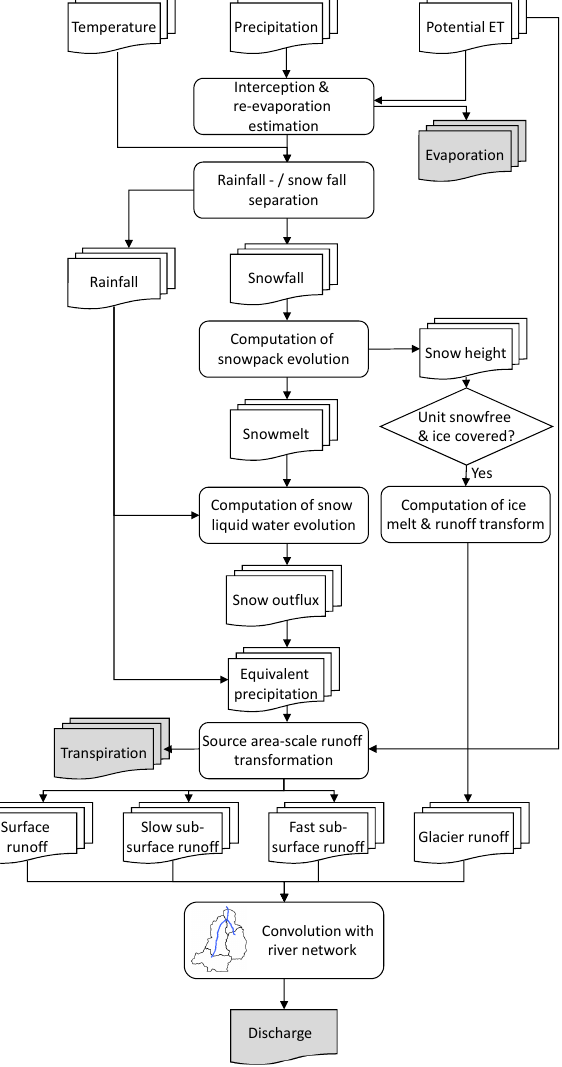
Figure 1. Flow diagram of the precipitation–discharge computa- tion. The grey boxes highlight the model output time